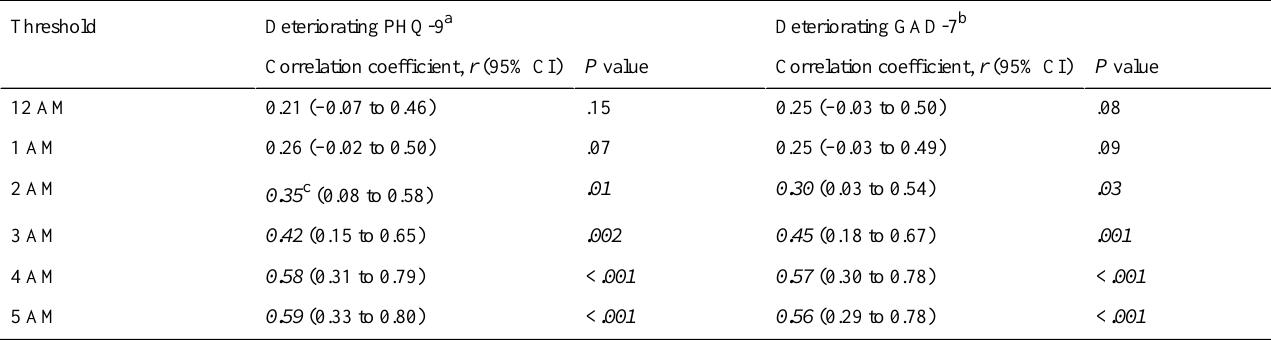
Table 3. The correlation coefficients between the change in the median time of last seen events and deteriorating PHQ-9 and GAD-7 scores at different threshold